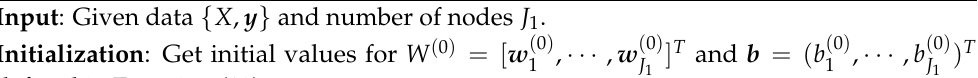
Algorithm 2 Local Linear Approximation (LLA) Algorithm for